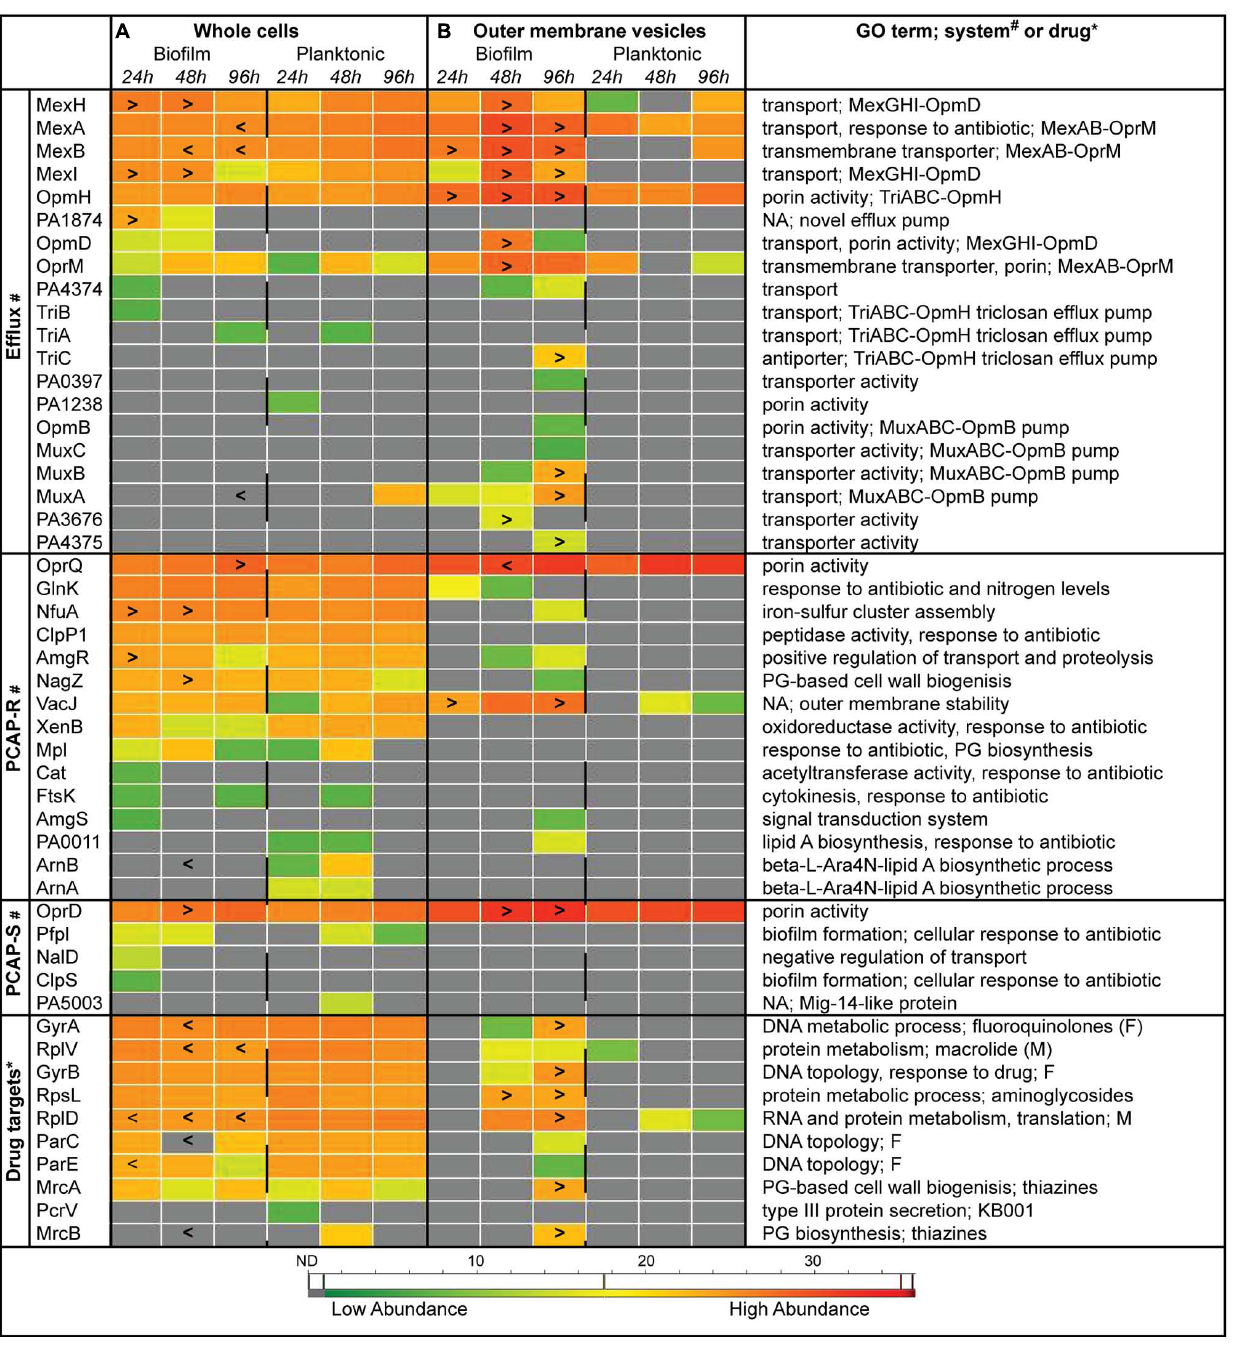
than time- and sample type-matched planktonic controls (e.g., 24 h biofilm whole cells vs. 24 h planktonic whole cells; p < 0.05); “ < ,” biofilm protein abundance is significantly less than time- and sample type-matched planktonic controls ( p < 0.05); * and # denotes categories where a specific system or drug is listed for the protein, respectively. F, fluoroquinolones; M, macrolides; NA, none available; ND, not detected, gray boxes; PCAP-R, PCAP-resistance; PCAP-S, PCAP-susceptibility; PG,